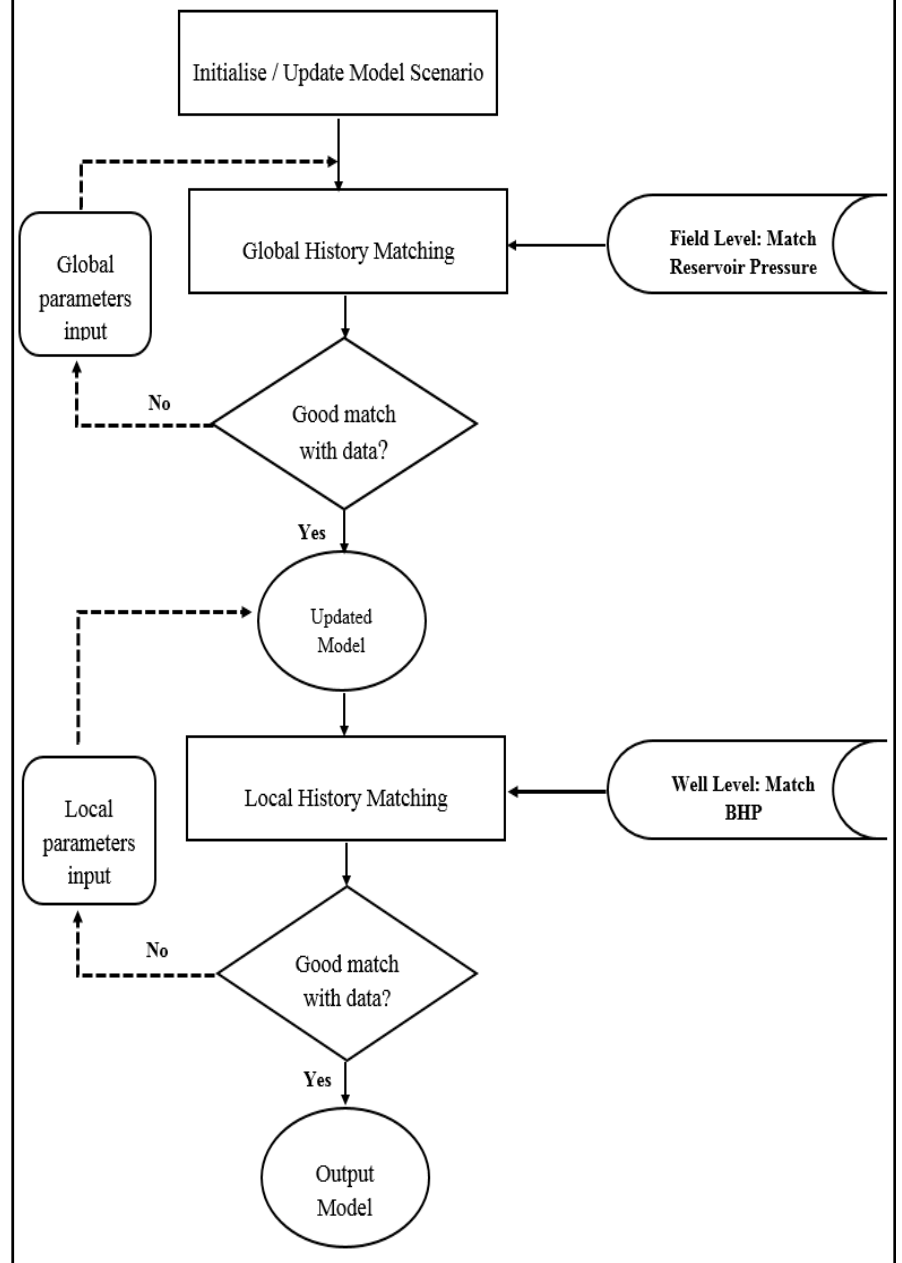
Figure 32. History matching workflow without TIF modelling.